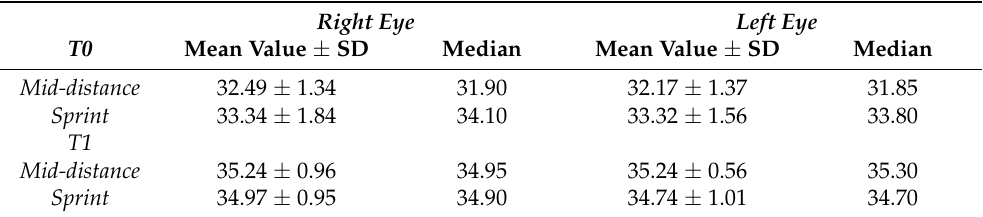
eye in T0 and T1 in dogs that participated in the mid-distance and sprint competition. All values are expressed in ◦ C. No significant differences were observed between T1 values comparing mid-distance and sprint races.